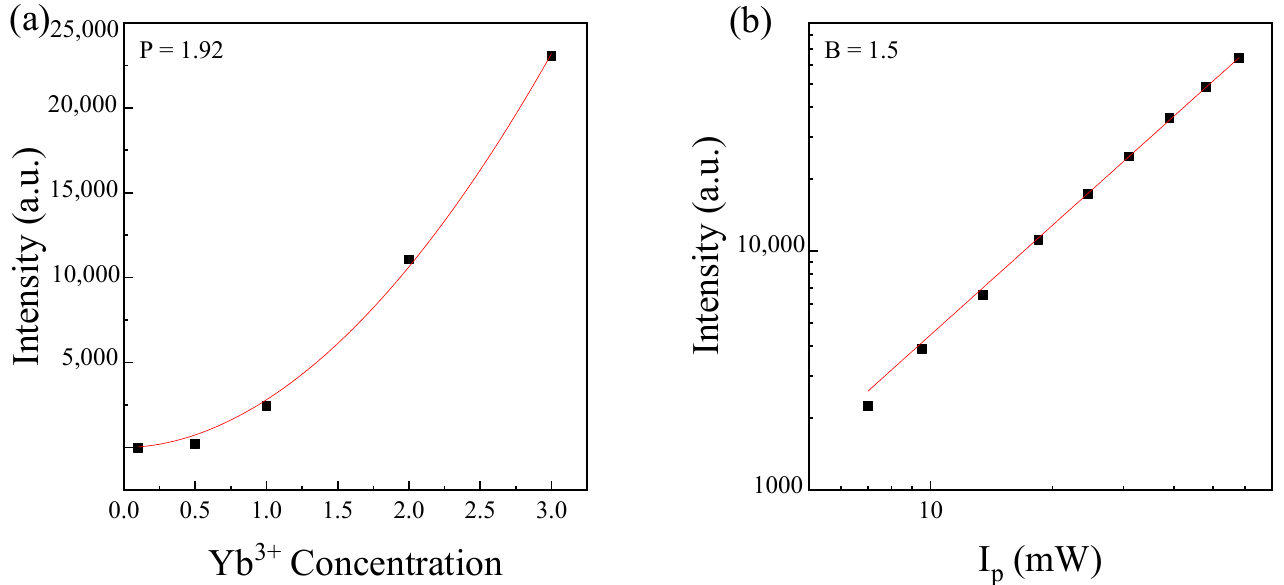
Figure 7. Tb 3+ emission intensity as a function of Yb 3+ concentration fitted to Equation (3) (solid line) ( a ). Plot of the 5 D 4 → 7 F 5 emission intensity as a function of pumping power (I p ) at 980 nm obtained in a 2.5Tb 3+ -3Yb 3+ co-doped phosphate glass ( b ).